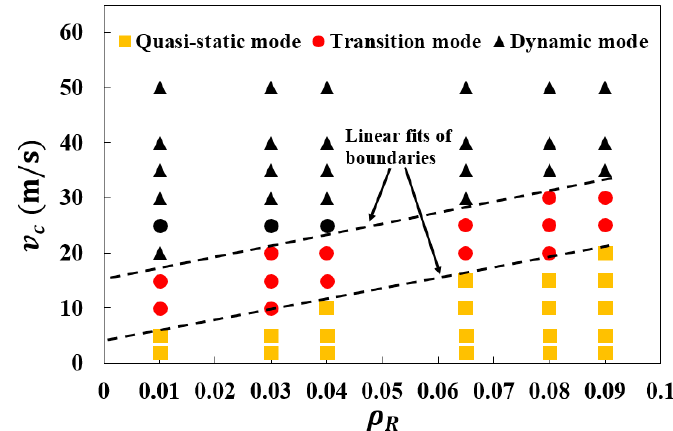
Figure 8. Mode classification map for the 3D re-entrant auxetic structures under dynamic crushing. The markers are the simulation results showing different crushing modes. The dashed lines represent the linear fits of boundaries associated with the transition among three specific crushing modes.